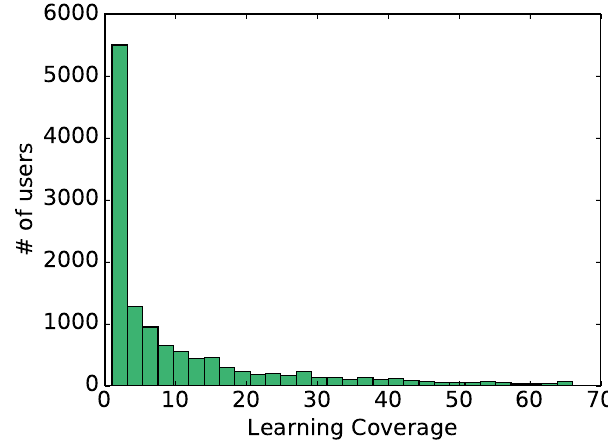
Figure 3. Histogram of the learning coverage of a course.